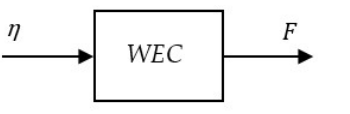
Figure 10. Block diagram for the static response of the WEC.